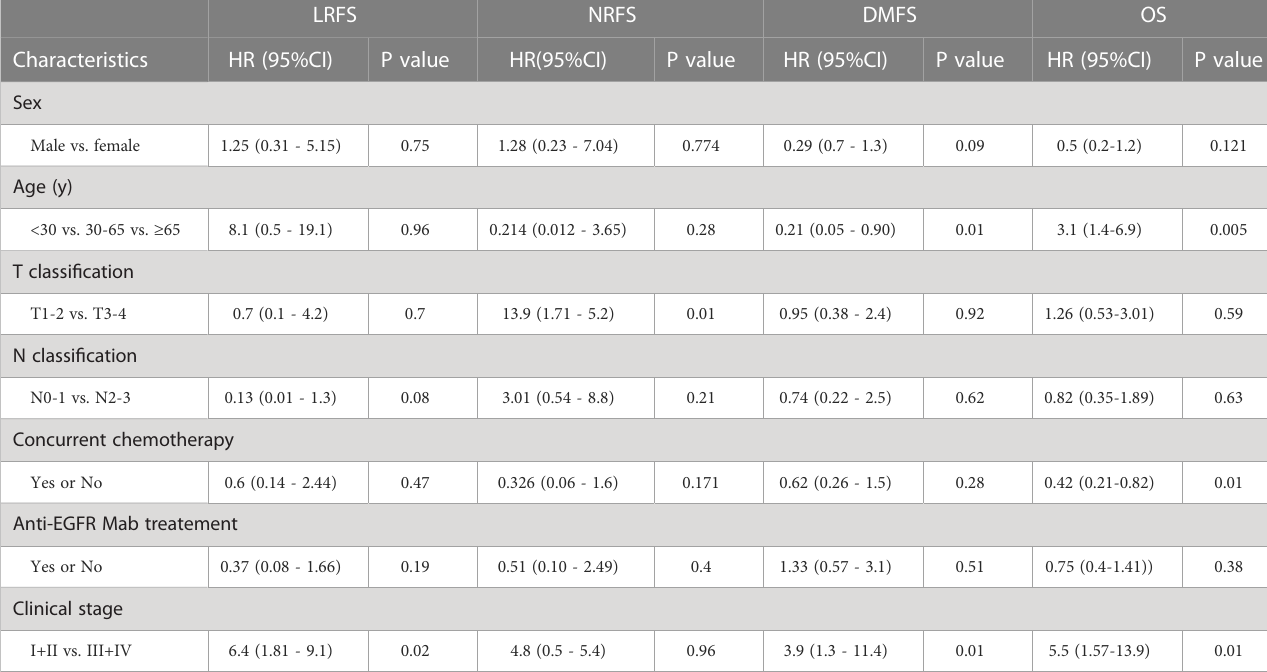
TABLE 4 Multivariate analysis of prognostic factors for 190 patients. LRFS NRFS DMFS OS Characteristics